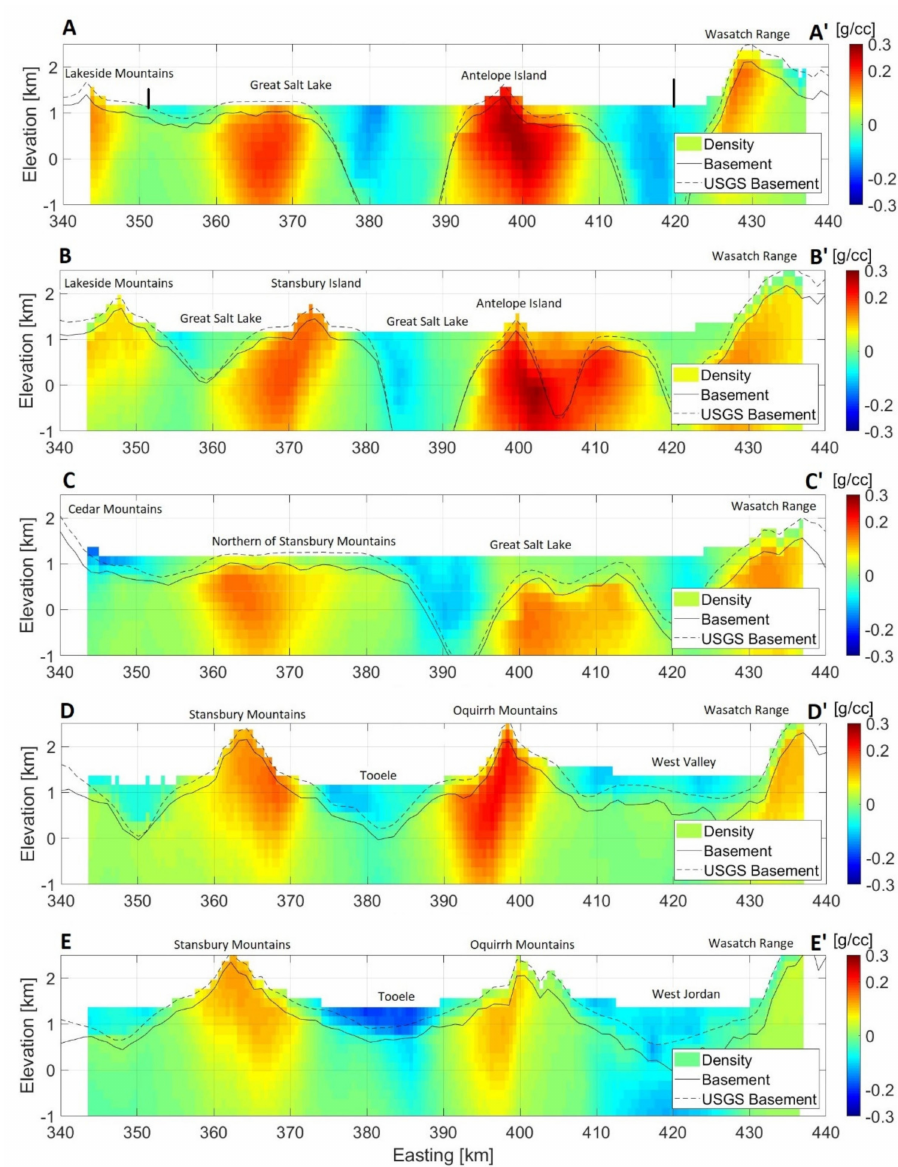
Figure 13. Combined vertical sections along all five profiles shown in Figure 6 of 3D density model produced by the inversion with a priori density contrast